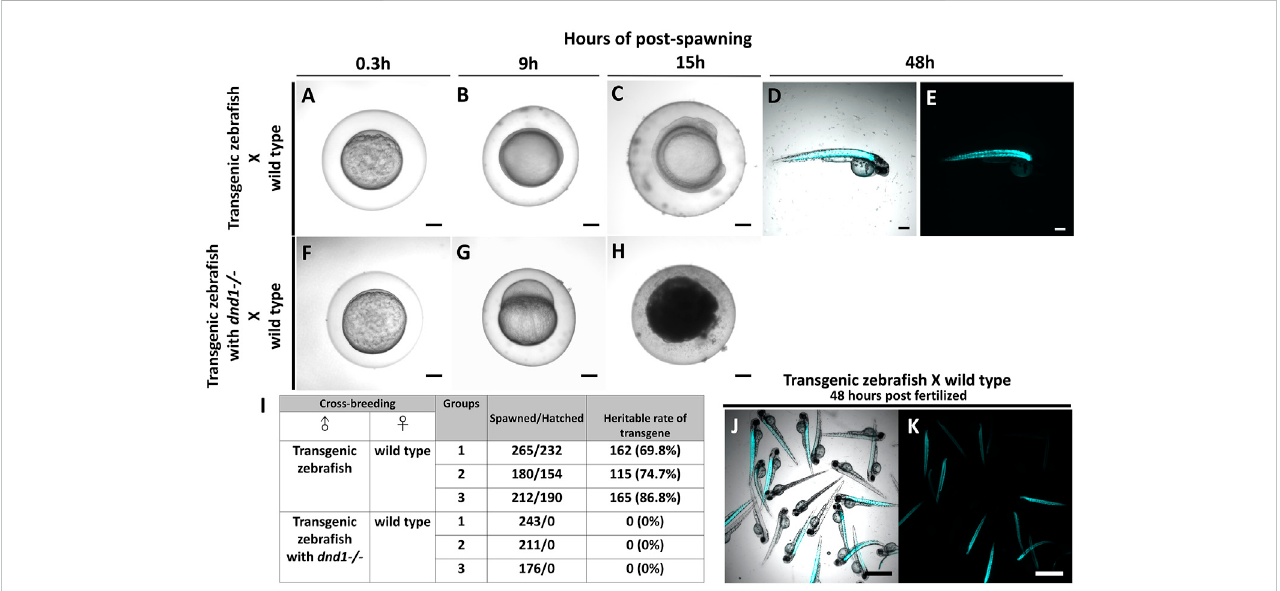
FIGURE 8 Transgenic zebra fi sh with dnd1 mutant can effectively avoid the transgene inherited. The eggs spawned by transgenic zebra fi sh and wild type zebra fi sh (A) .3 h (B) 9 h (C) 15 h (D) 48 h of post spawning under light view (E) 48 h of post spawning under dark view. The eggs spawned by transgenic zebra fi sh with dnd1 mutant and wild type zebra fi sh (F) .3 h (G) 9 h (H) 15 h. (I) The heritable rate counting of transgene in cross-breeding group. Top view of hatched offspring of cross-breeding by transgenic zebra fi sh and wild type zebra fi sh. (J) light view (K) dark view. Bars = 200 μ m (A – H) and 500 μ m (J, K)